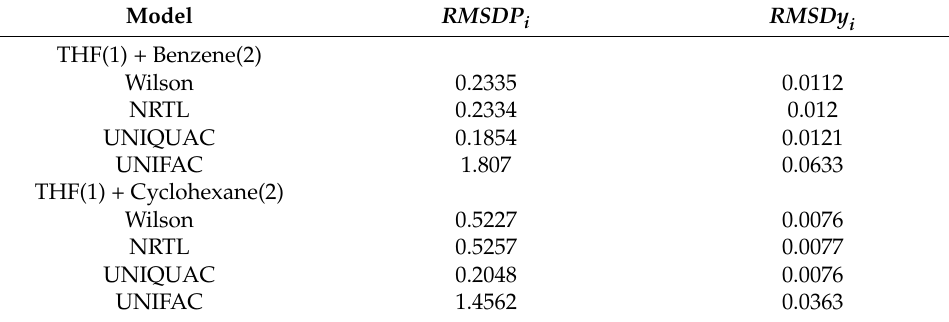
Table 7. RMSD for the isothermal systems.